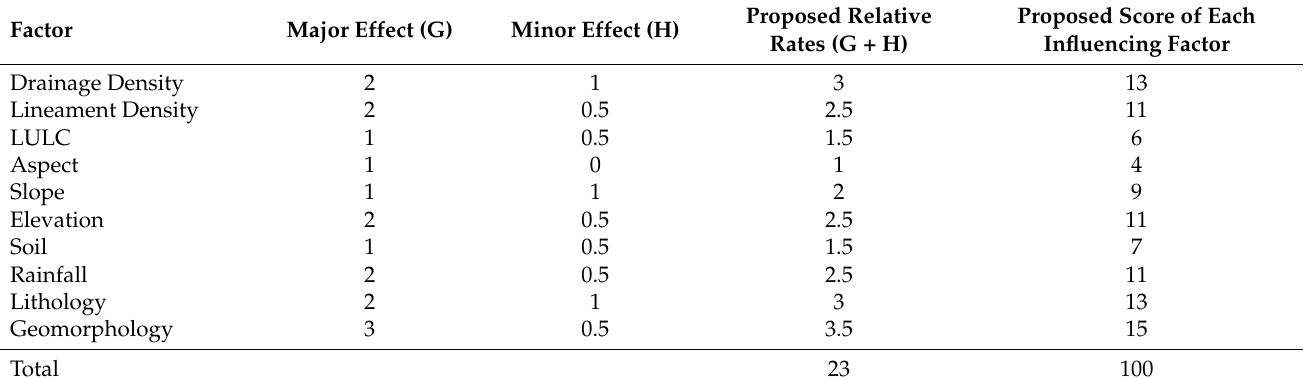
Table 1. Impact of influencing factor, proposed score, and each potential factor’s relative rates.